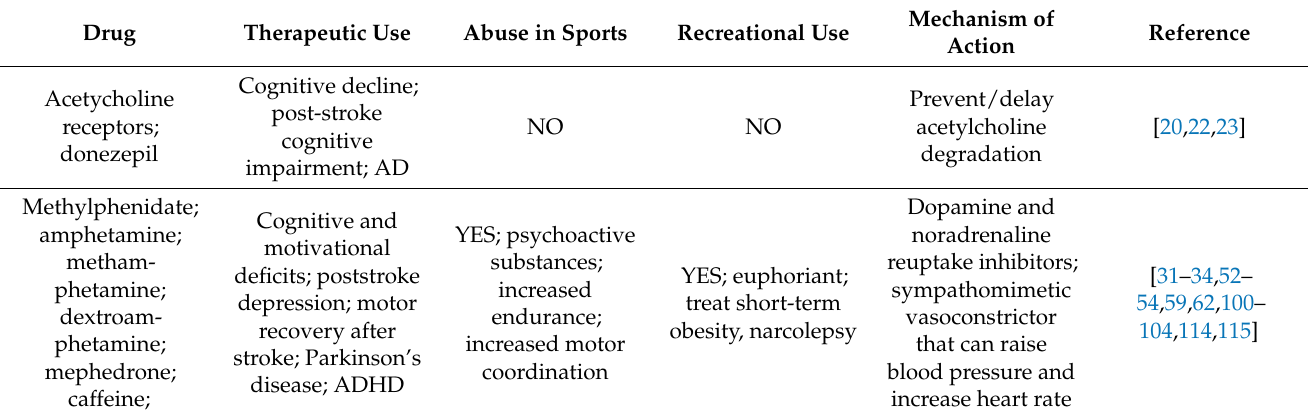
Table 1. Overview of therapeutic use and abuse of brain stimulants to enhance athletic performance and recreational